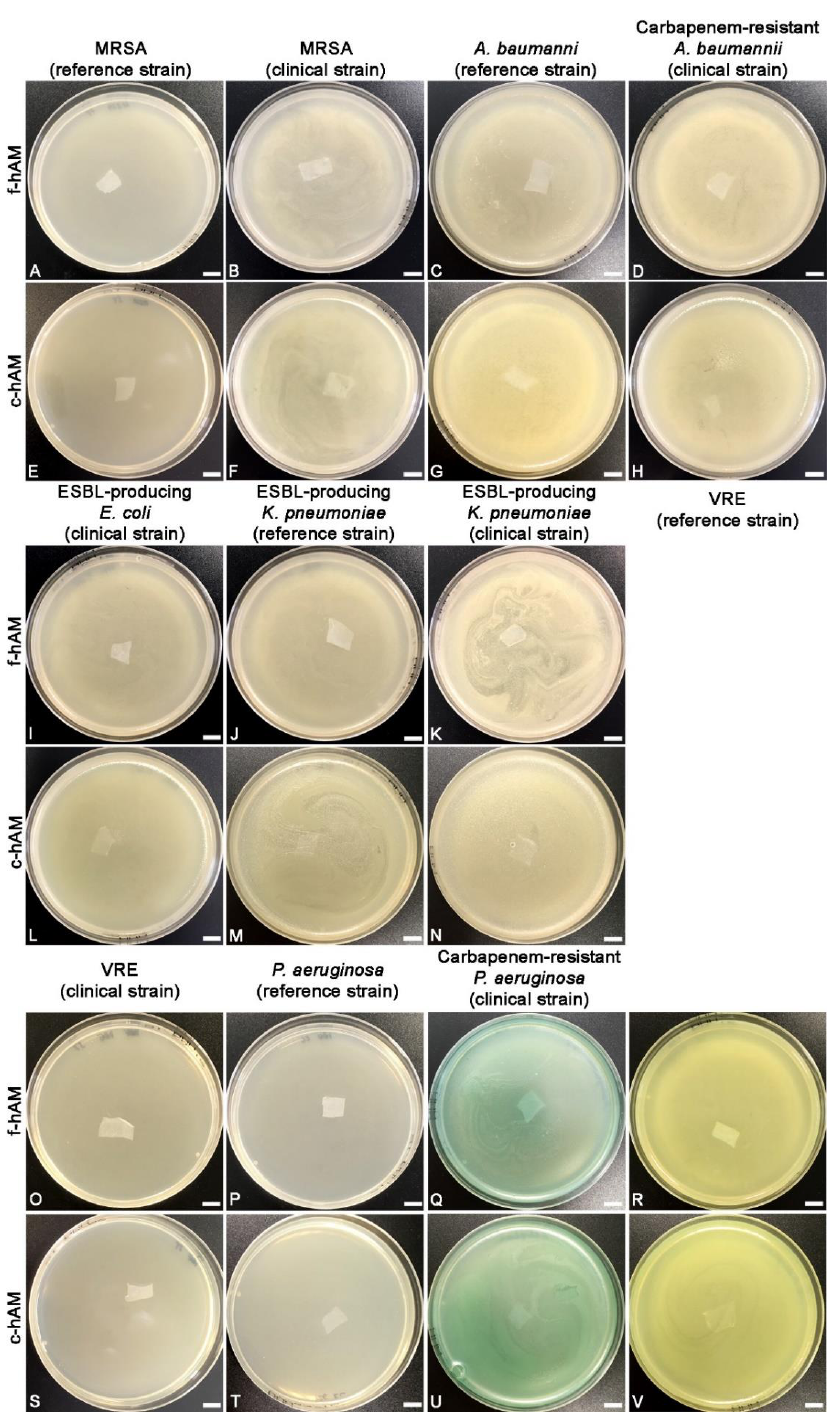
Figure 1. The human amniotic membrane (hAM) patches have no antibacterial activity against tested multidrug-resistant bacteria. Neither the application of fresh-hAM (f-hAM) patches ( A – D , I – K , O – R ) nor the application of cryopreserved hAM (c-hAM) patches ( E – H , L – N , S – V ) resulted in an inhibition zone in any of the tests. Data were obtained from three independent replications of experiments using three biological samples of hAM and three technical repeats for each biological sample and each independent replication of the experiment. Scale bars: 10 mm.